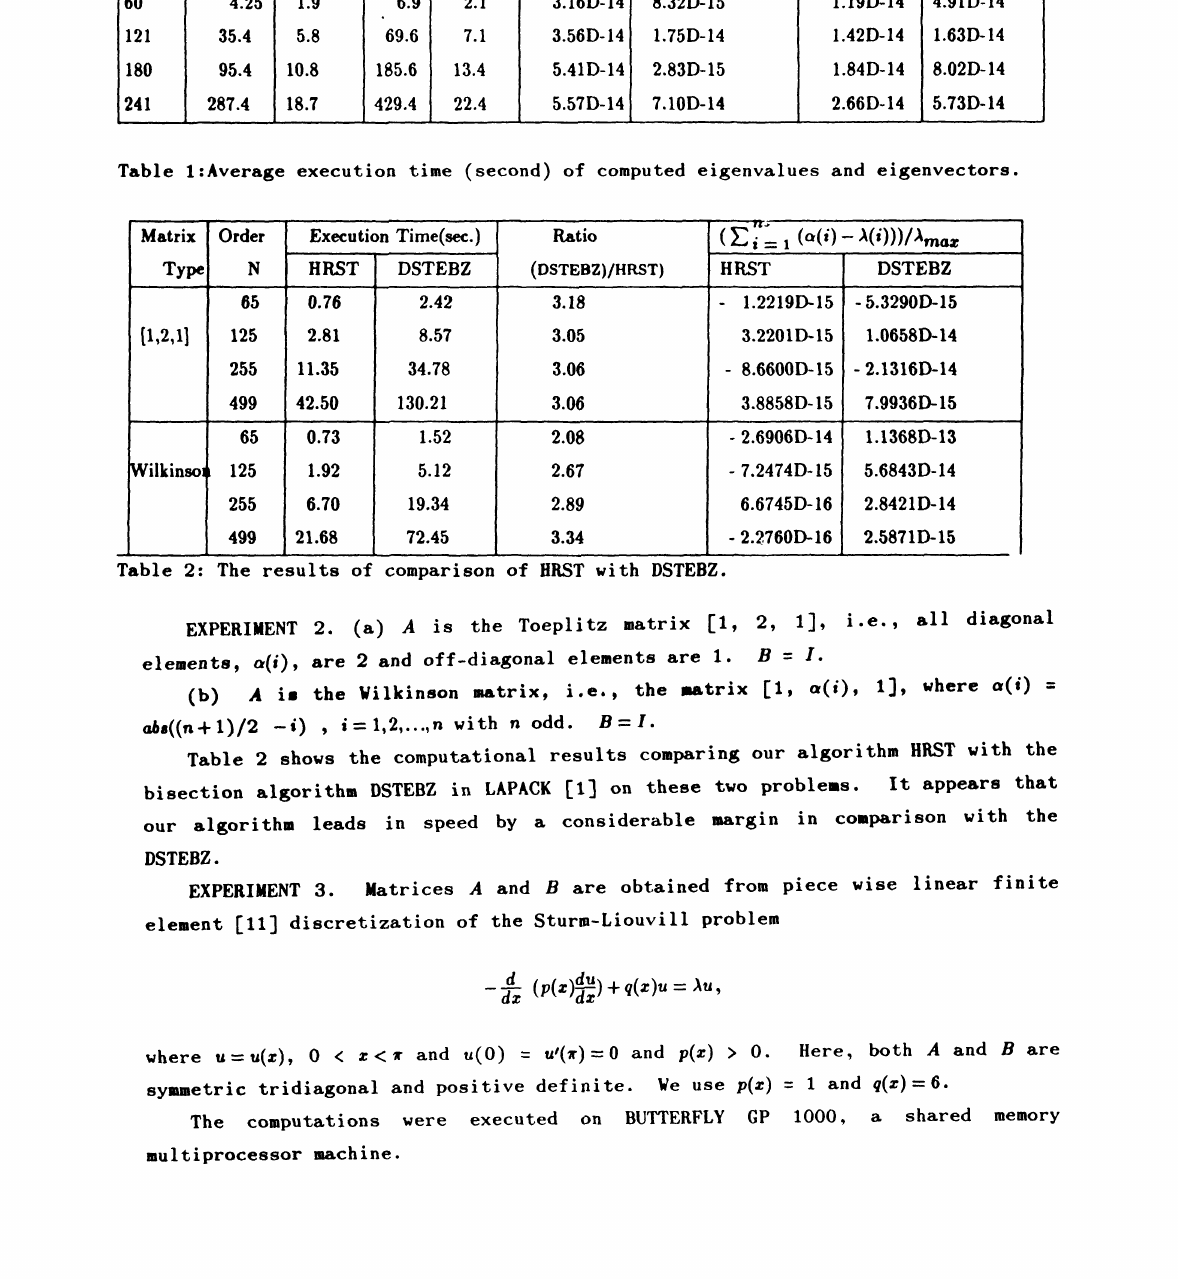
able 2: The results of comparison of HRST with